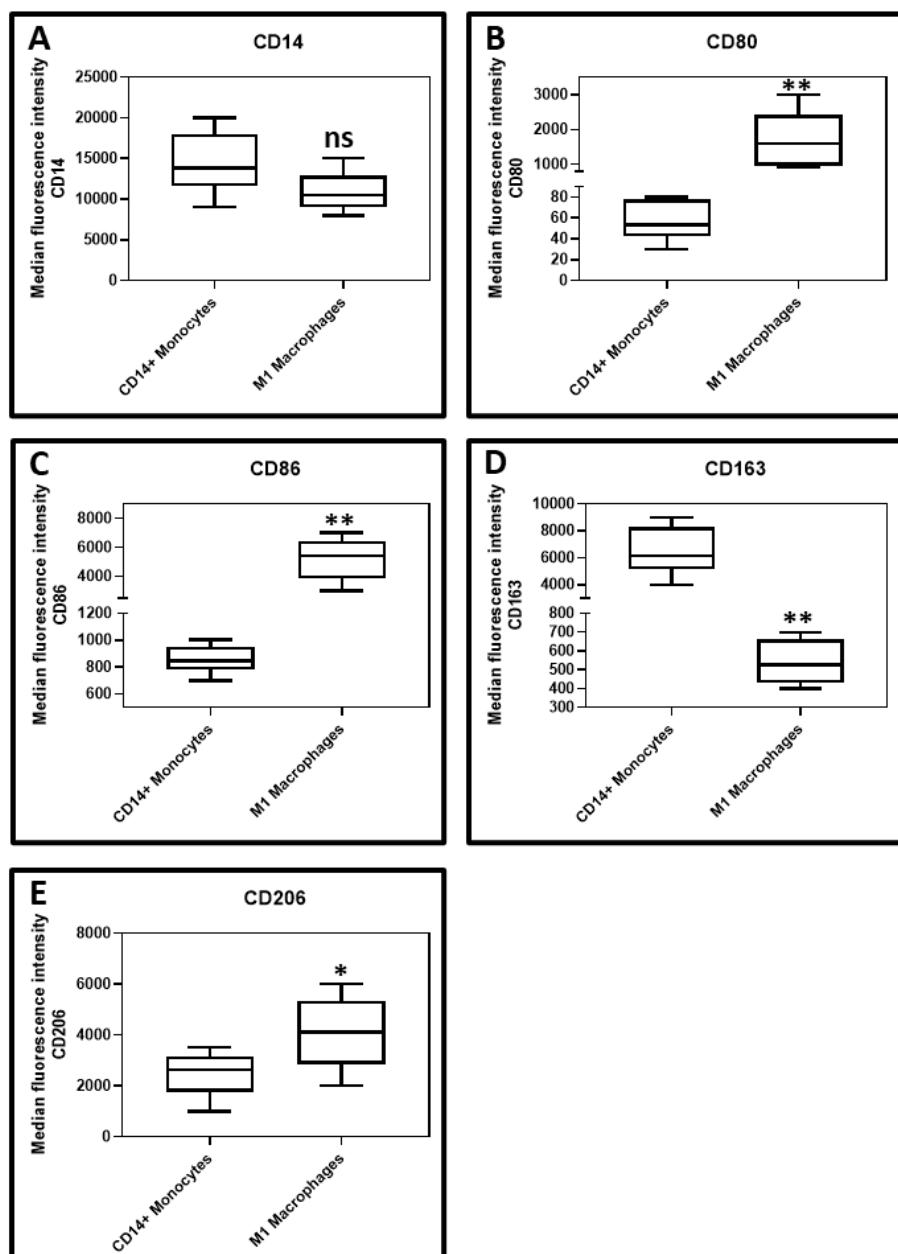
Figure 3. Comparative cell surface analysis between GCF differentiated macrophages and untreated CD14+ monocytes for ( A )—CD14 ( p = 0.0551), ( B )—CD80 (** p < 0.0001), ( C )—CD86 (** p < 0.0001), ( D )—CD163 (** p < 0.0001), ( E )—CD206 (* p = 0.0455) respectively.